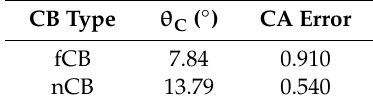
Figure 6. Percentage inhibitions achieved by non-functionalized CB (nCB)/CS/AChE sensors for three different concentrations of carbofuran versus the % inhibitions for the same concentrations of pesticide recorded with the use of functionalized CB (fCB)/CS/AChE sensors. The measurements were taken in triplicate. Table 1. Contact angle measurements of fCB/CS and nCB/CS modified electrodes.